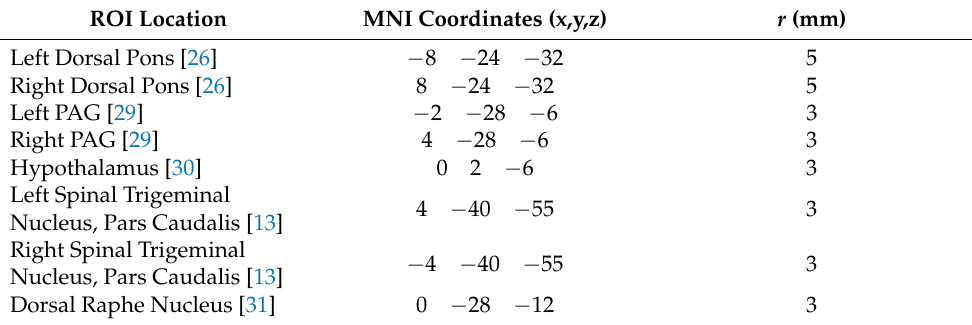
Table 1. List of the regions of interests (ROI) and relative details (anatomical location, coordinates, according to the Montreal Neurological Institute coordinate system (MNI), of the centroid and radius of the sphere) added to the customised atlas considered for the seed-based correlation analysis. ROI Location MNI Coordinates (x,y,z) r (mm) Left Dorsal Pons [26] − 8 − 24 − 32 5 Right Dorsal Pons [26] 8 − 24 − 32 5 Left PAG [29] − 2 − 28 − 6 3 Right PAG [29] 4 − 28 − 6 3 Hypothalamus [30] 0 2 − 6 3 Left Spinal Trigeminal 4 − 40 − 55 3 Nucleus, Pars Caudalis [13] Right Spinal Trigeminal − 4 − 40 − 55 3 Nucleus, Pars Caudalis [13] Dorsal Raphe Nucleus [31] 0 − 28 − 12